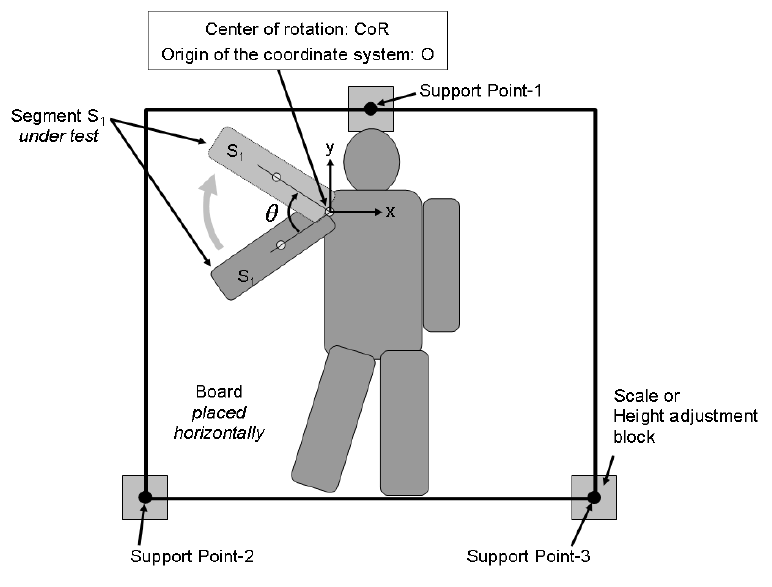
Figure 2. Setup for measuring the center of mass CoM of a subject body.